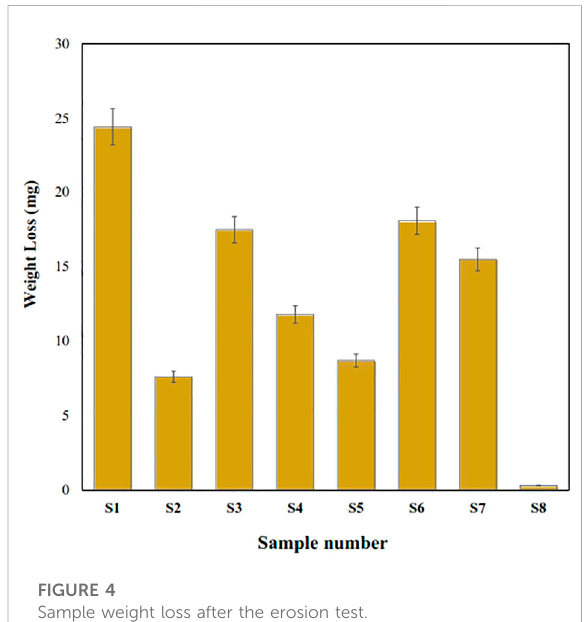
FIGURE 4 Sample weight loss after the erosion